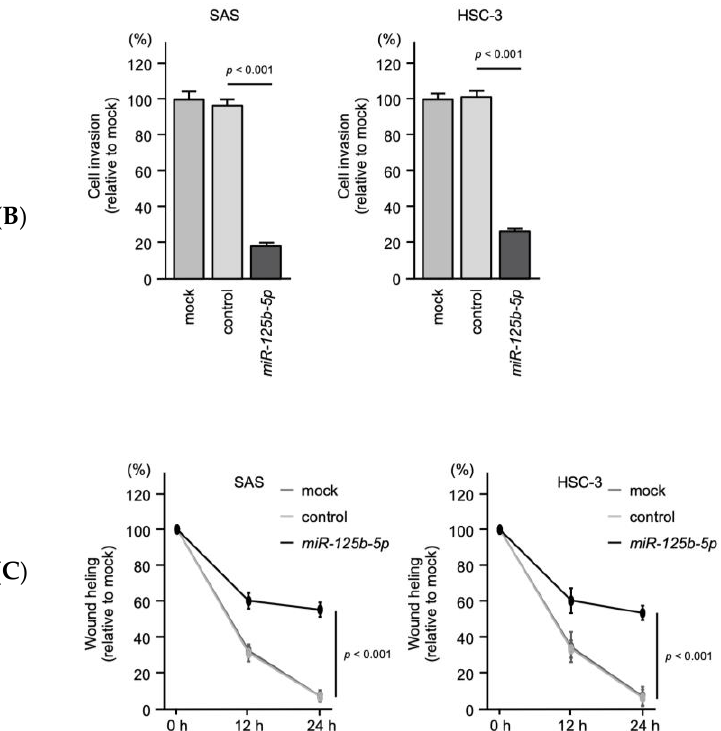
Figure 10. Tumor-suppressive function of miR-125b-5p in OSCC cells. ( A ) Cell proliferation assessed with an XTT assay at 72 h after transfection of mature miRNAs. ( B ) Cell invasion determined with a Matrigel invasion assay at 48 h after seeding miRNA-transfected cells into the chambers. ( C ) Cell migration was assessed with a wound-healing assay. Data were collected 0 h, 12 h, and 24 h after cell scratch.